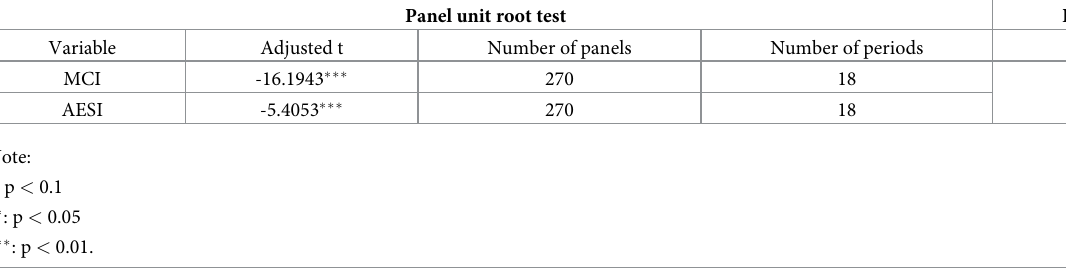
Table 3. Results of panel unit root test (PURT) and panel co-integration test (PCIT) of MCI and